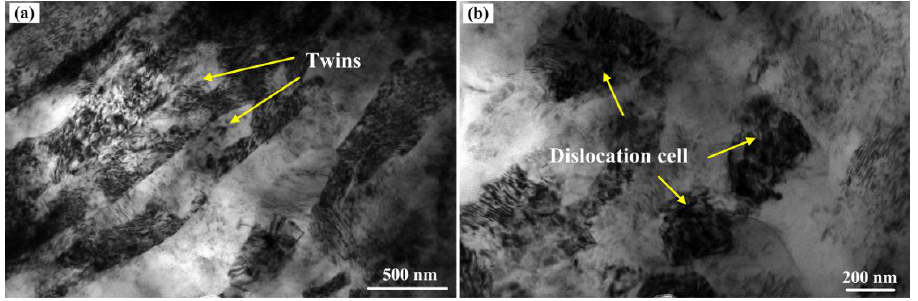
Figure 5. TEM image of the 160-μm deformed layer from the top surface. ( a ) Twins and ( b ) dislocation cells.